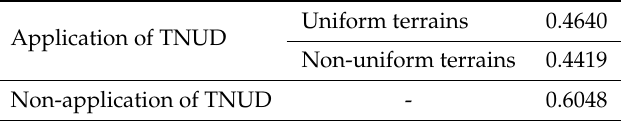
Table 3. Prediction error for failed cases.